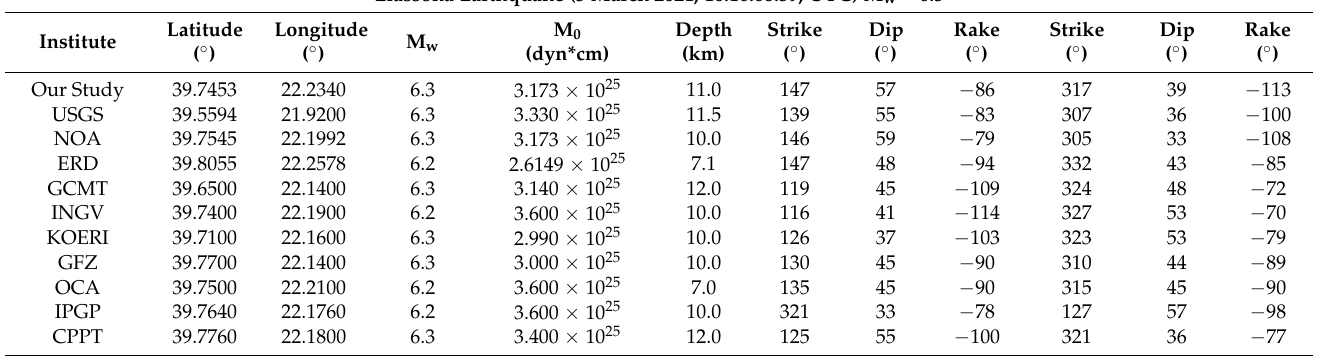
Table 2. List of moment tensor solutions published by various institutions and universities for 3 March 2021 (10:16:08.3, UTC) and 4 March 2021 (18:38:19.1, UTC). Source: CSEM—EMSC Available at: <https://www.emsc-csem.org/> (accessed on 8 June 2022)